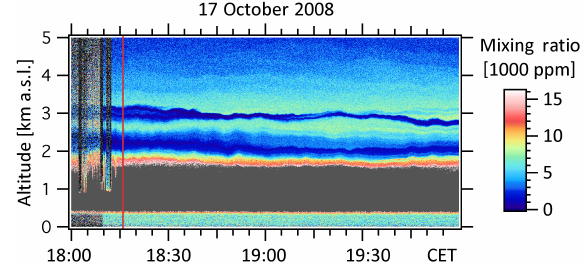
Figure 5. Water-vapour time series of CAELI on 17 October 2008 (Bilthoven); the time of the aircraft overflight (18:16CET) is marked by a red vertical line. In the graph, only the data from the far-field receiver are shown (above 1.7km). The profiles are shown at the full native resolution of 10s and 7.5m.